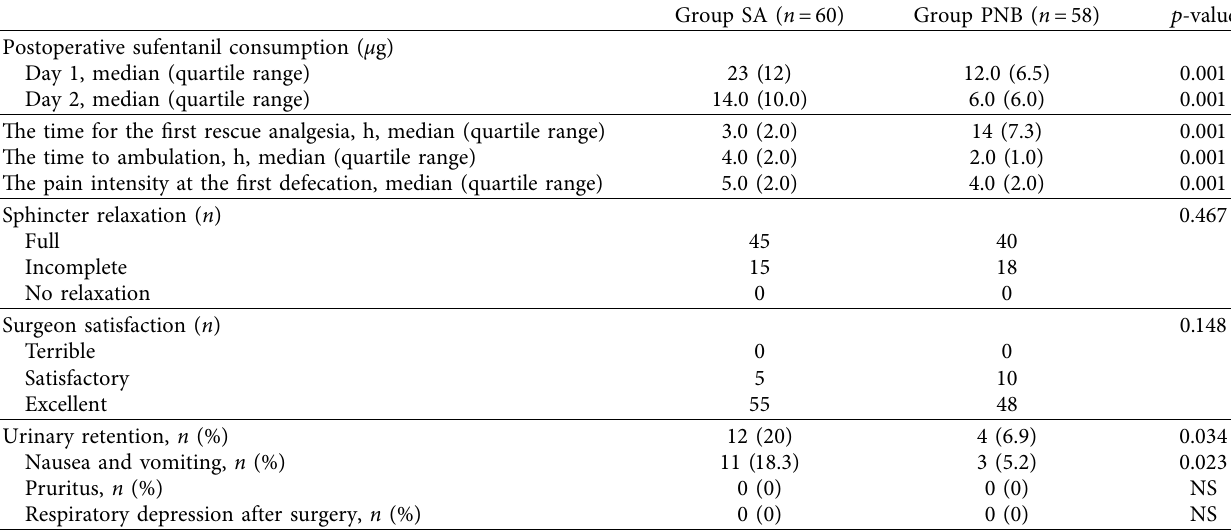
Table 3: Secondary outcomes